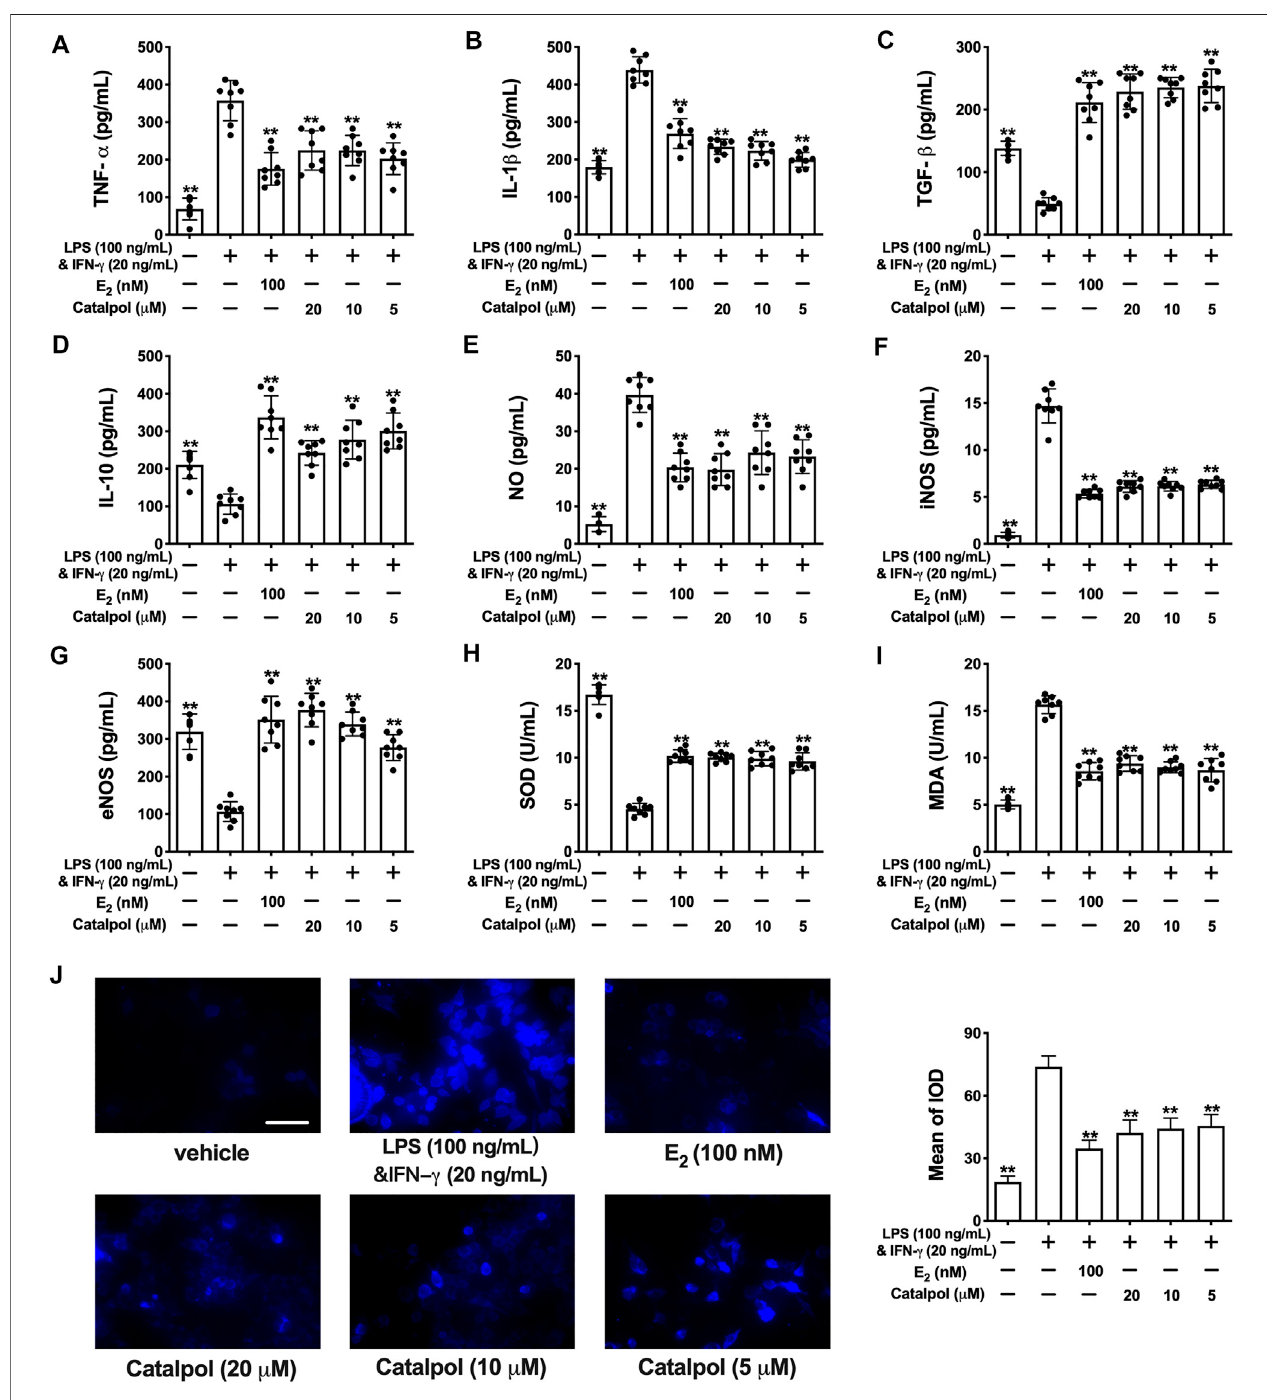
FIGURE 2 | Catalpol attenuated in fl ammatory response and oxidative stress in M1 macrophages. (A, B) Effects of catalpol on the levels of pro-in fl ammatory cytokines(TNF- α andIL-1 β )( n (cid:2) 8); (C,D) Effectsofcatalpolonthelevelsofanti-in fl ammatorycytokines(TGF- β andIL-10)( n (cid:2) 8); (E,G) Effectsofcatalpolonthelevelsof NO,iNOS andeNOS ( n (cid:2) 8); (H,I) Effects ofcatalpol onthe levelsofSOD andMDA ( n (cid:2) 8); (J) Effect ofcatalpol onthelevel ofROSwasstainedbyimmuno fl uorescence ( n (cid:2) 3). Data are expressed as mean ± SD. * p < 0.05, ** p < 0.01 vs. LPS&INF- γ group.